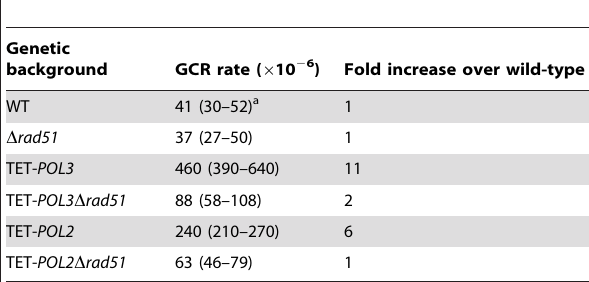
Table 2. Alu -IR-mediated fragility in TET- POL3 and TET- POL2 mutants is Rad51-dependent.